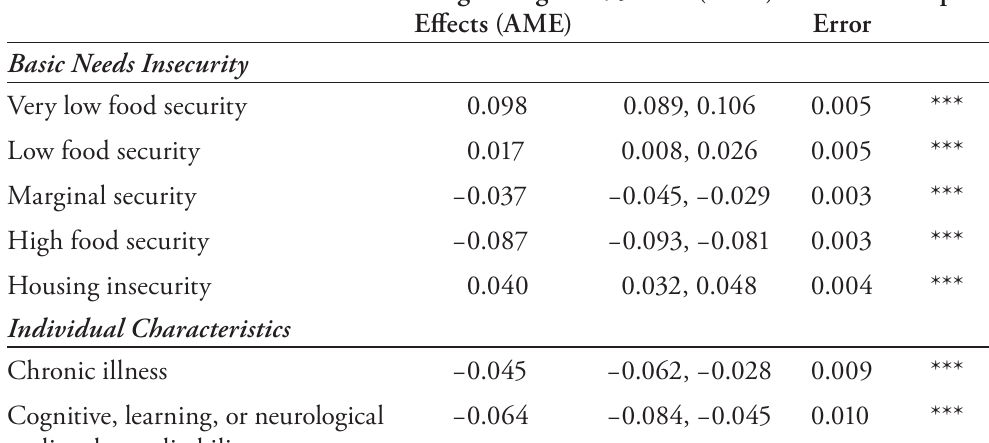
Table 3. Results of the Logistic Regression for Generalized Anxiety Disorder (GAD)